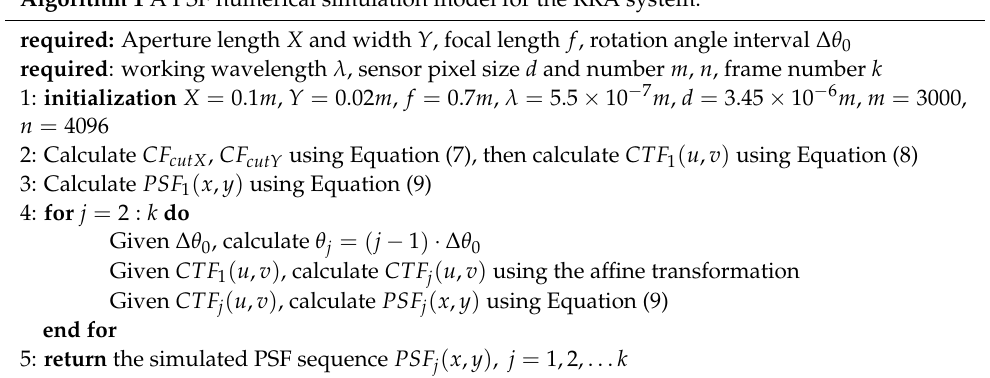
Figure 7. Simulated CTFs and the corresponding PSF patterns. ( a – d ) CTF pattern when the primary mirror is rotated 0 ◦ , 45 ◦ ,90 ◦ , and 135 ◦ clockwise. ( e – h ) PSF patterns corresponding to ( a – d ). Algorithm 1 summarizes the main procedure of a PSF’s numerical simulation. Algorithm 1 A PSF numerical simulation model for the RRA